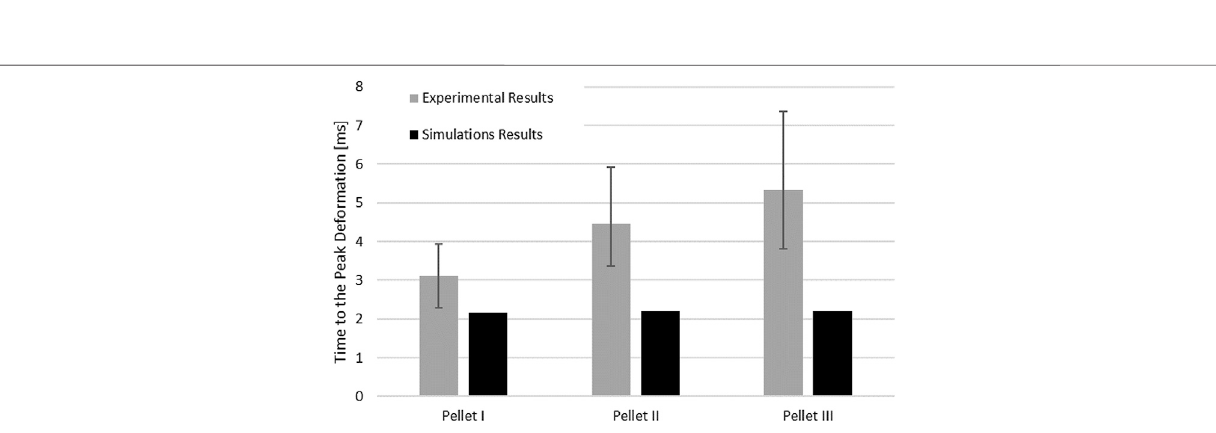
( Figure 10 ). Simplifying the pia mater to linear elastic material properties resulted in maximum deformation below the experimental range. On average the maximum